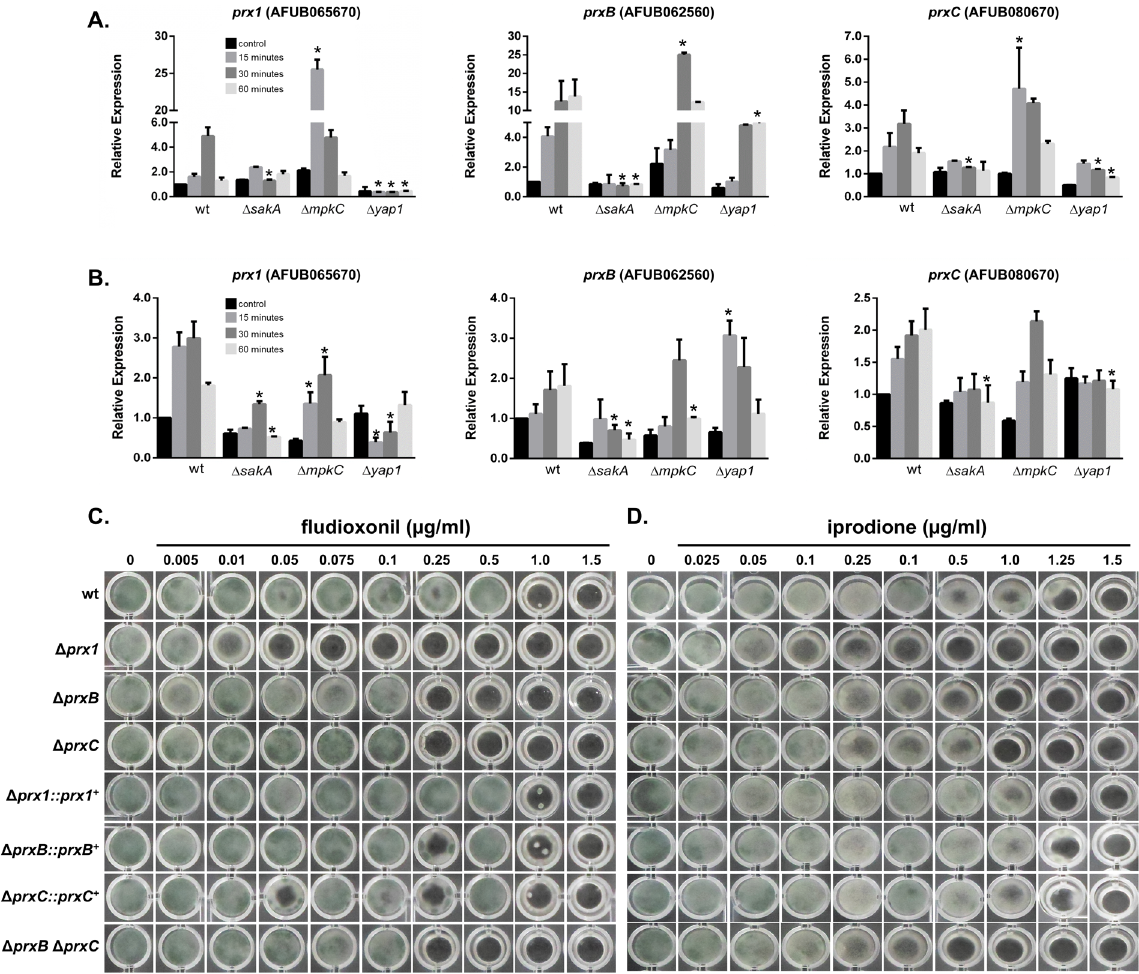
Figure 9. Expression of A . fumigatus Prxs is regulated by sakA HOG1 and yap1 YAP1 in the presence of paraquat and fludioxonil. ( A , B ) mRNA abundance of prx1 , prxB and prxC is impacted by the MAP kinase SakA while the expression of prx1 and prxC is regulated by the Yap1 transcription factor. Wild-type, Δ sakA , Δ mpkC and Δ yap1 mutant strains were grown in MM for 24 h and subjected to treatment with fludioxonil (1 µ g/ml; A) or paraquat (10 mM; B) for 15, 30 or 60 minutes. The control was left untreated. The mRNA abundance for each gene was assessed by RT-qPCR and normalized to β -tubulin. The data represent the average value of three biological replicates, each of which was repeated in duplicate in the same run, Bar = SD, * p ≤ 0.05 (one-way ANOVA). ( C , D ) The Prx deletion mutants are more sensitive to fludioxonil and iprodione. 1 × 10 4 conidia of each strain were grown on MM containing increasing concentrations of fungicides. The cultures were grown for 72 h at 37 °C. The results are representative of four independent